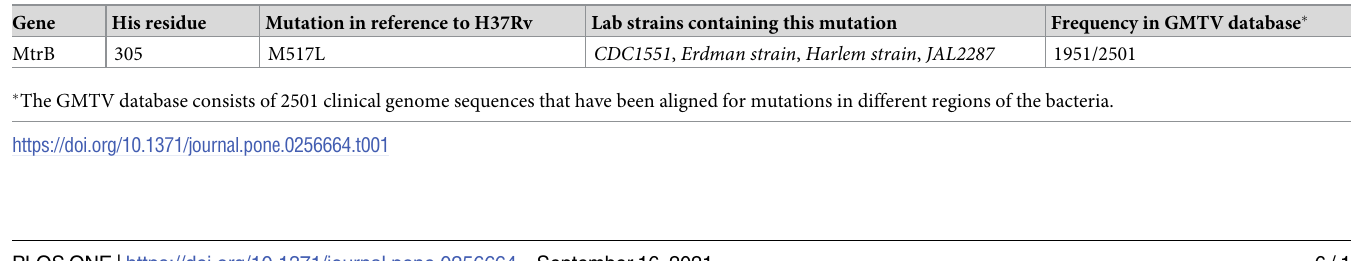
PLOS ONE | https://doi.org/10.1371/journal.pone.0256664 September 16,